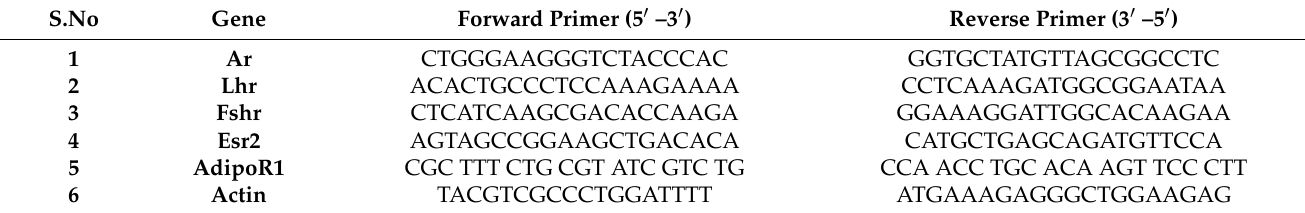
Table 1. List and sequence of primers used for the analysis of